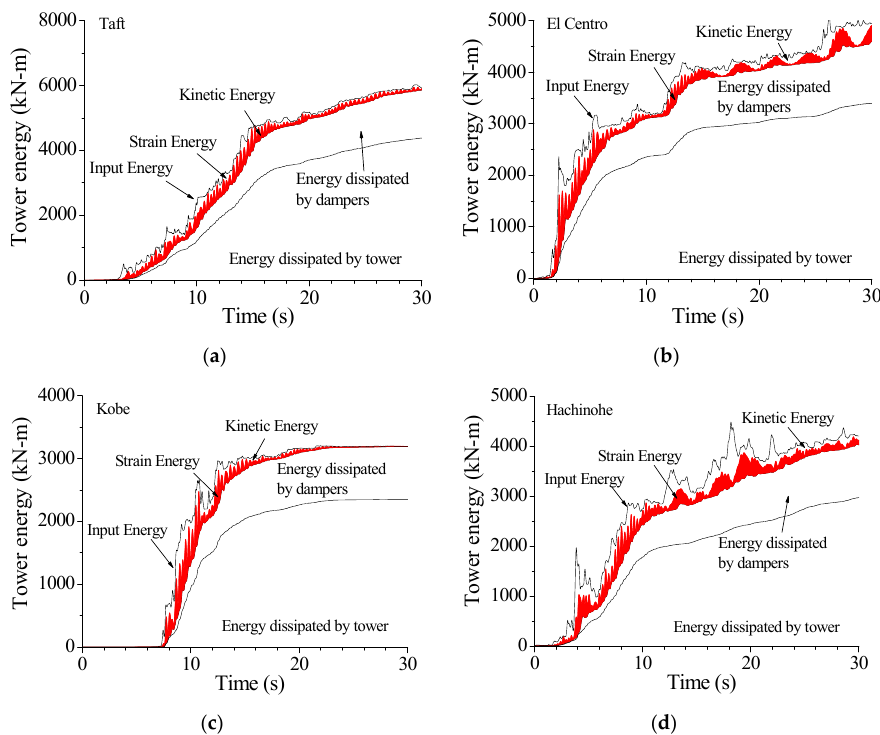
Figure 19. Energy responses of the tower with SMA dampers. ( a ) Taft; ( b ) El Centro; ( c ) Kobe; ( d ) Hachinohe.